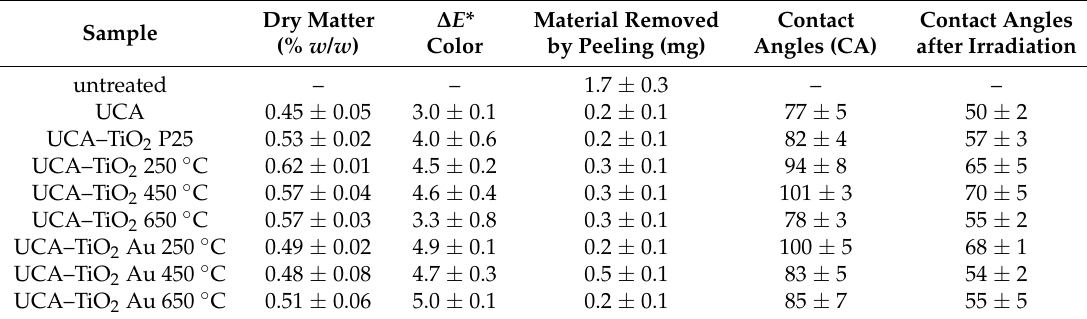
Table 2. Properties of the treated stone specimens and the untreated counterparts. ∆ E * Dry Matter Material Removed Contact Contact Angles Sample (% w / w ) Color by Peeling (mg) Angles (CA) after Irradiation untreated – – 1.7 ± 0.3 –